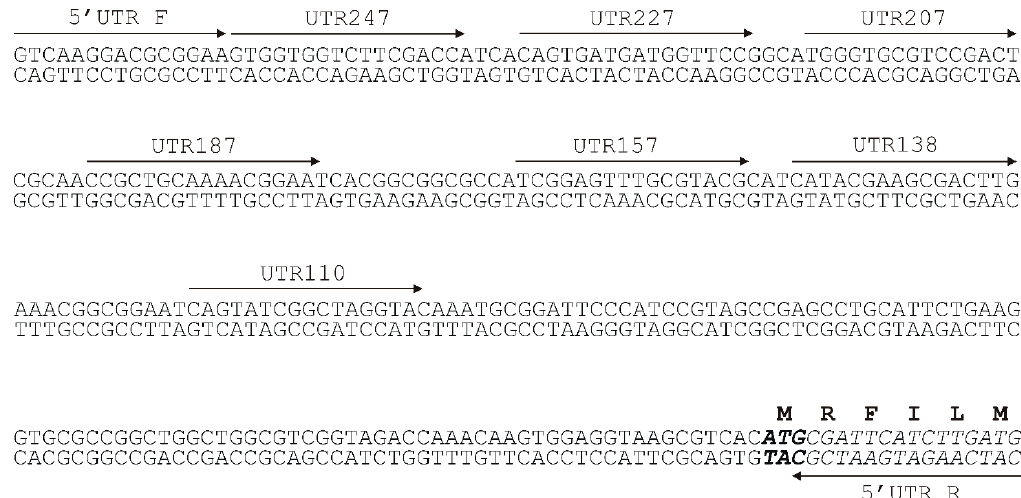
Figure 2. A scheme for the determination of a minimal promoter sequence. The primers used for the amplification of the upstream region of the tpdA gene are marked with arrows. The amplified DNA fragments were fused to the egfp gene in pART3-gfp.